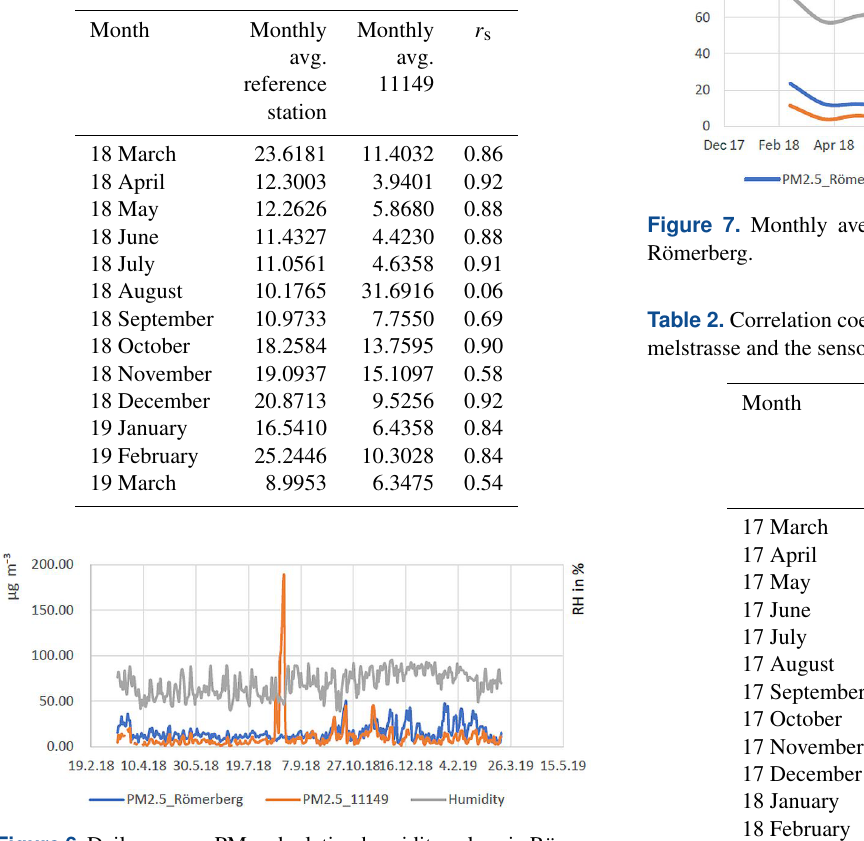
Figure 6. Daily average PM and relative-humidity values in Römer- berg.